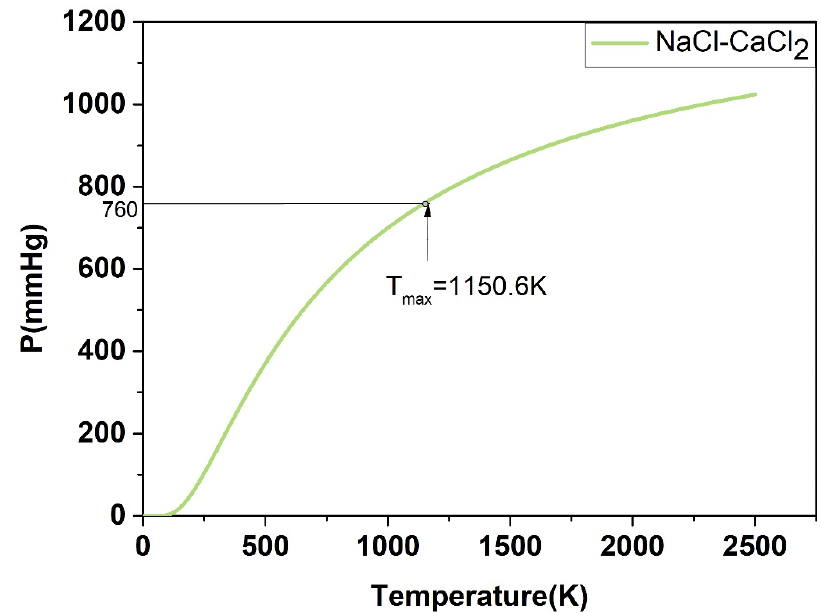
Figure 17. Calculated P ‐ T phase diagram of the NaCl ‐ KCl binary system.